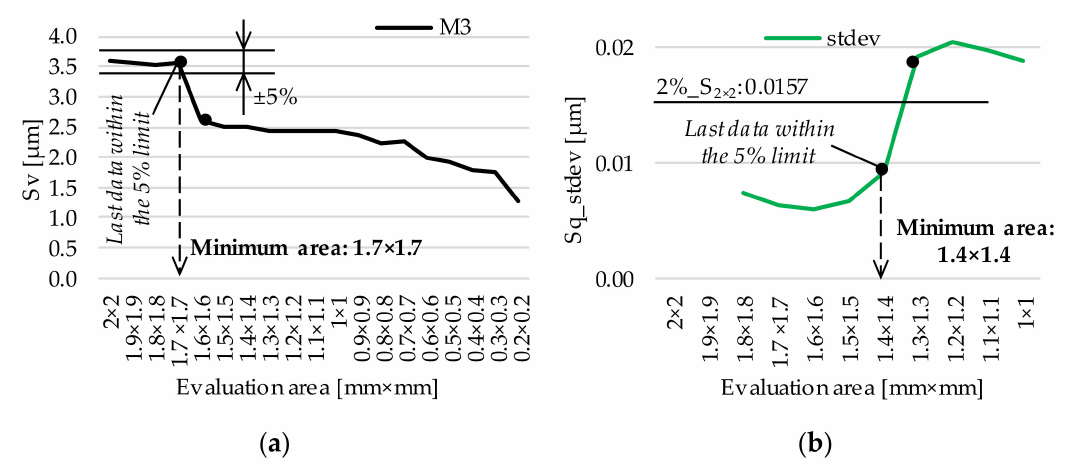
Figure 11. Schemes of designation minimum evaluation areas with limits set based on ( a ) roughness values and their ( b ) standard deviations.